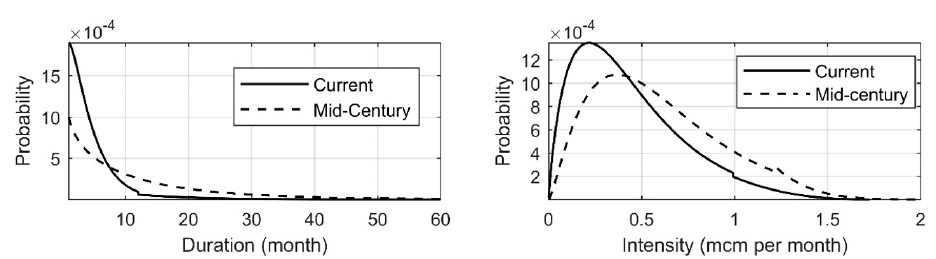
Figure 9. ( left-panel ) Probability distribution functions of drought durations; and ( right-panel ) probability distribution functions of drought intensities.